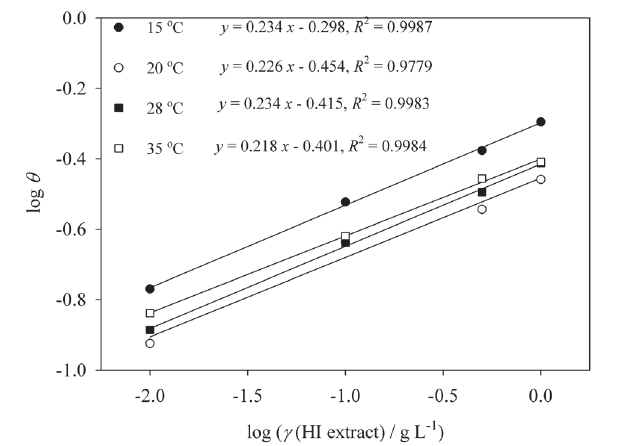
Fig. 3 – Freundlich adsorption isotherm for HI extract at dif­ ferent temperatures (shown in figure)